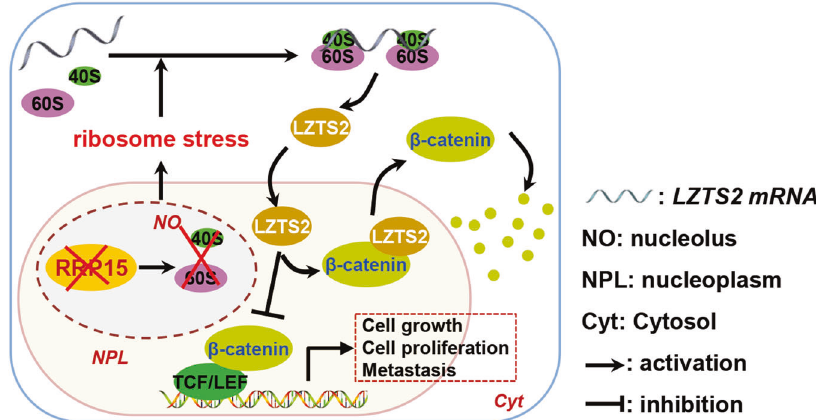
Fig. 8 The model of RRP15 regulates CRC progression. RRP15 plays a critical role in regulating RiBi. RRP15 de fi ciency-induced severe ribosome stress enhances the af fi nity of TOP mRNA LZTS2 with ribosome and promotes its translation, causing nuclear export and degradation of β -catenin, and thereby inhibiting cell proliferation and metastasis of